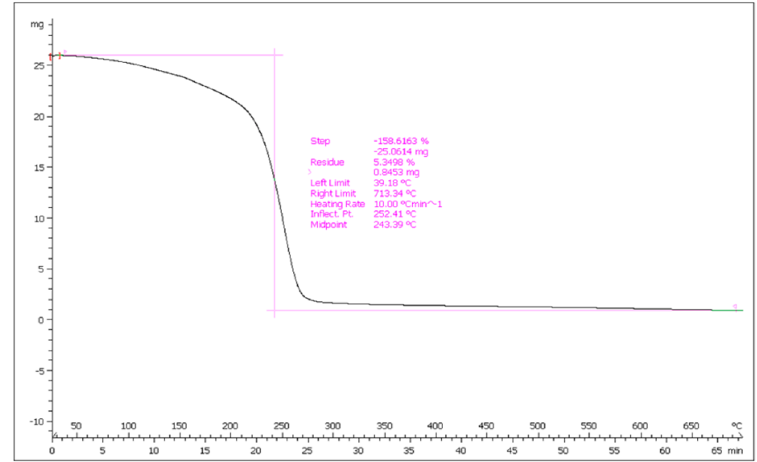
Figure 3. TGA thermogram of Bet/LA/W (1:2:2.5). Table 2. NaDES-UAE preliminary